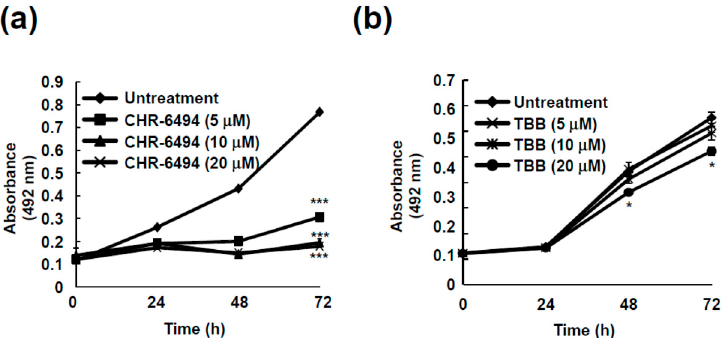
Figure 6. Cancer cell growth is modulated by haspin kinase but not casein kinase 2. ( a ) CHR-6494, a haspin kinase inhibitor and ( b ) TBB, a casein kinase 2 inhibitor, were treated to the cells and HCT116 cell growth was estimated using Cell Titer96 Aqueous One Solution (Promega) as described in the Materials and Methods. The asterisk (* and ***) indicates a significant difference (of p < 0.01 and p < 0.001, respectively) compared to the untreated group.